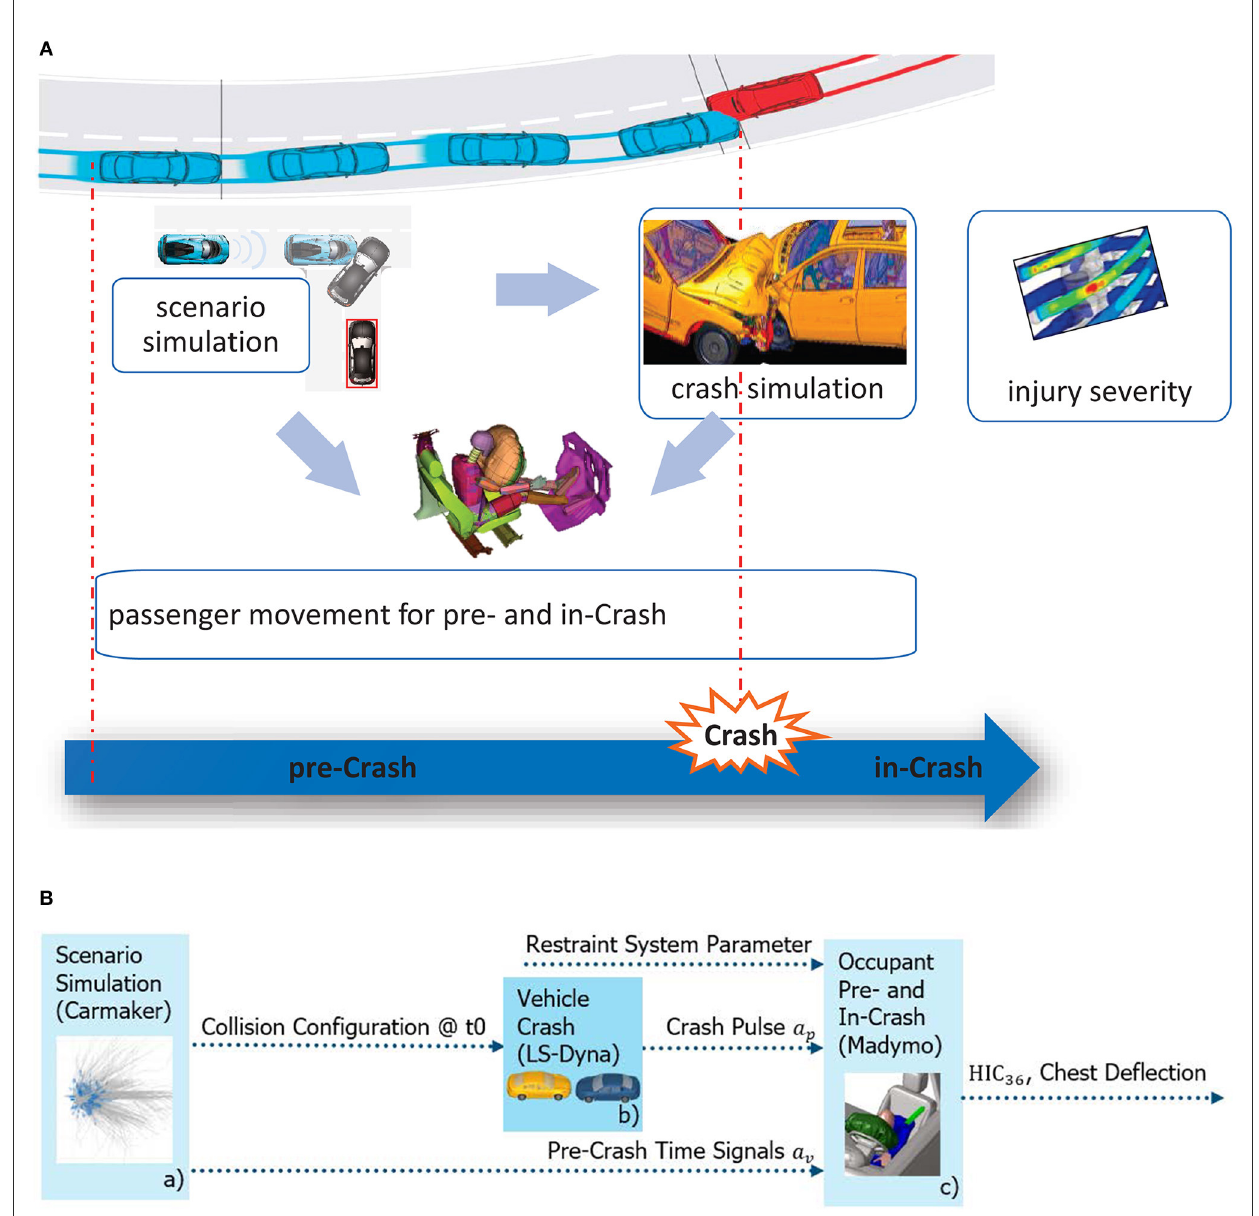
FIGURE2 (A) Scenario simulation, in Carmaker the behavior of the colliding vehicles is simulated in the pre-crash phase. The collision configuration at the crash is input to a LS-Dyna crash simulation. Furthermore the trajectory of the vehicles under test is input to the Madymo simulation to estimate/ simulate the occupant movement. In the final step the crash pulse from the in-crash simulation, the position of the occupant at the crash plus the parameters of the restraint system are simulated to calculate the injury severity. (B) Detailed description of the data-flow in the simulation framework for scenario-based safety performance assessment, combining scenario, vehicle crash and occupant restraint system simulation. The arrows describe the in- and outputs to the specific simulator